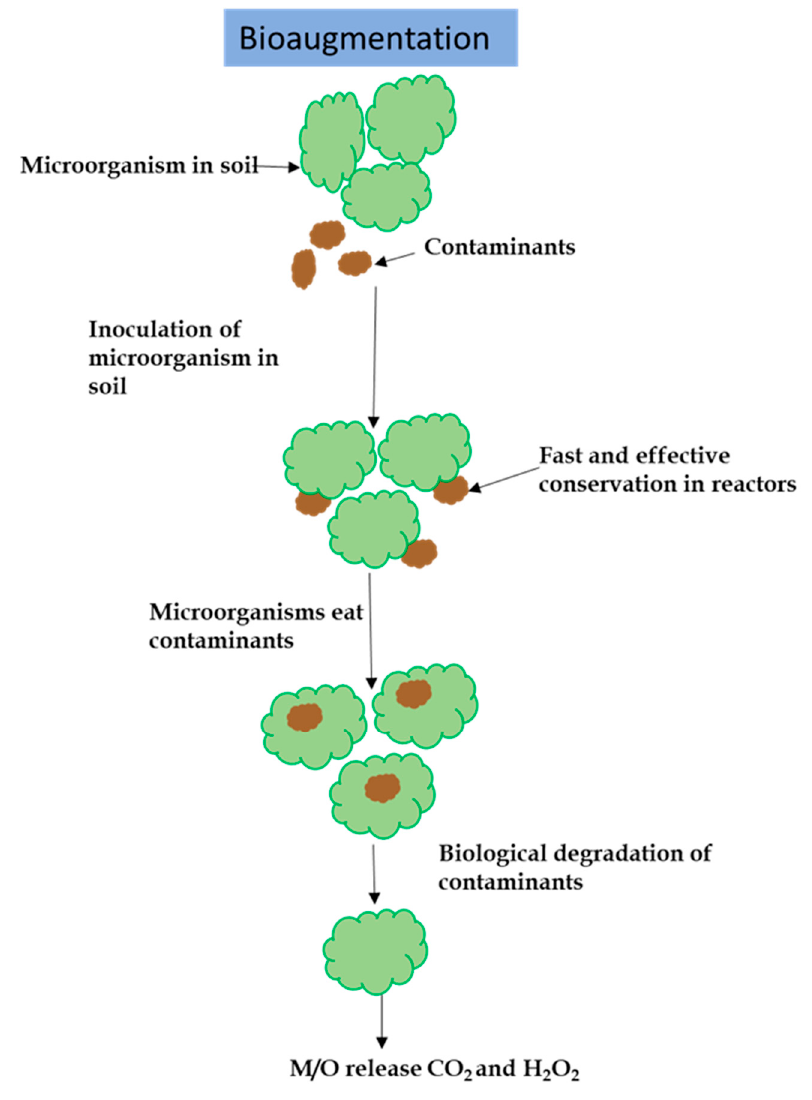
Figure 4. Bioaugmentation: the degradation of contaminants by microorganisms.